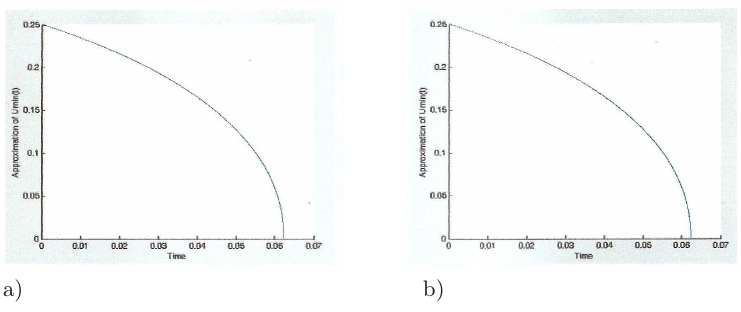
Figure 2. Profile of the approximation of U min t : a) Explicit scheme, b) Implicit scheme.